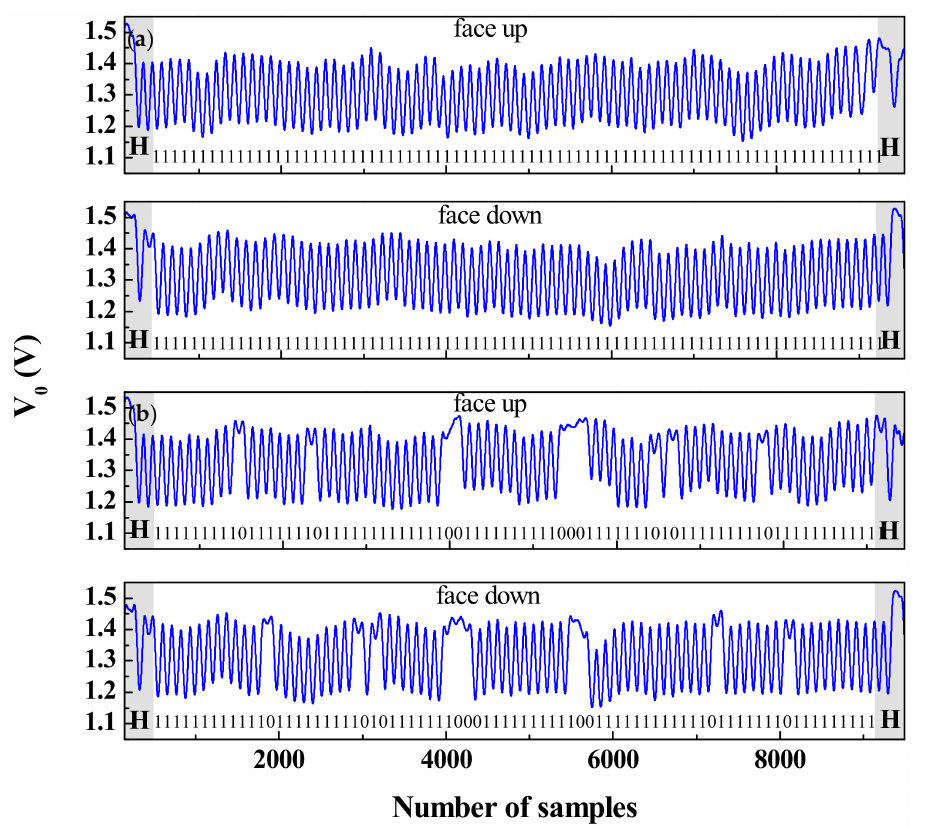
Figure 12. ( a ) Measured envelope of the inkjet-printed 80-bit tag with all bits set to the logic state ‘1’ and ( b ) 80-bit programmed tag with the indicated code. Figure extracted from